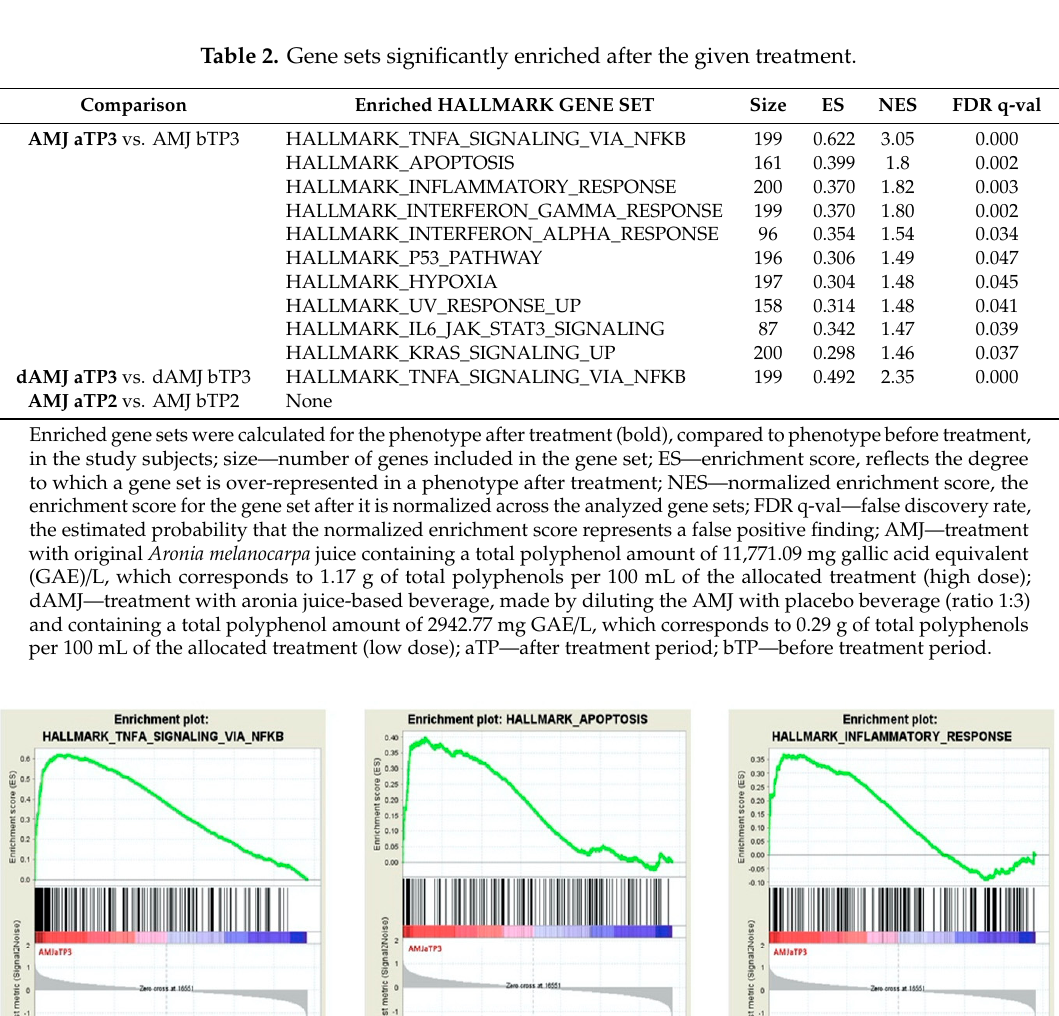
Table 2. Gene sets significantly enriched after the given treatment.